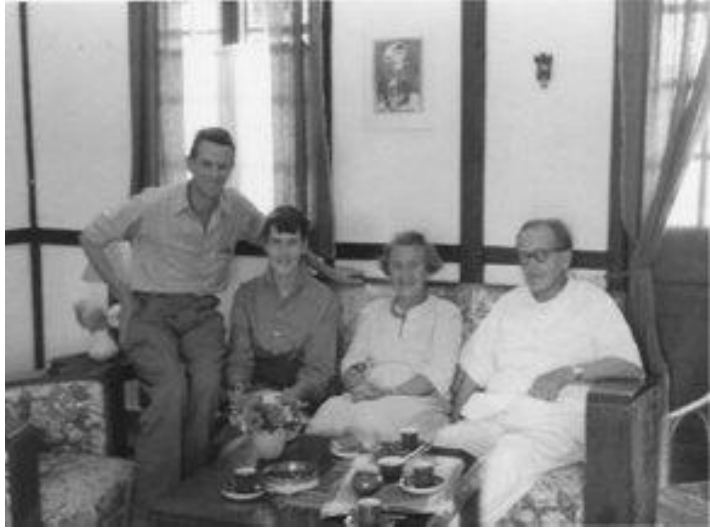
Figure 8. Axel and Signe Höjer with Dr. J.M.G. Wilson and his son Philip in the tea garden. Int. J. Neonatal Screen. 2020 , 6 , 15